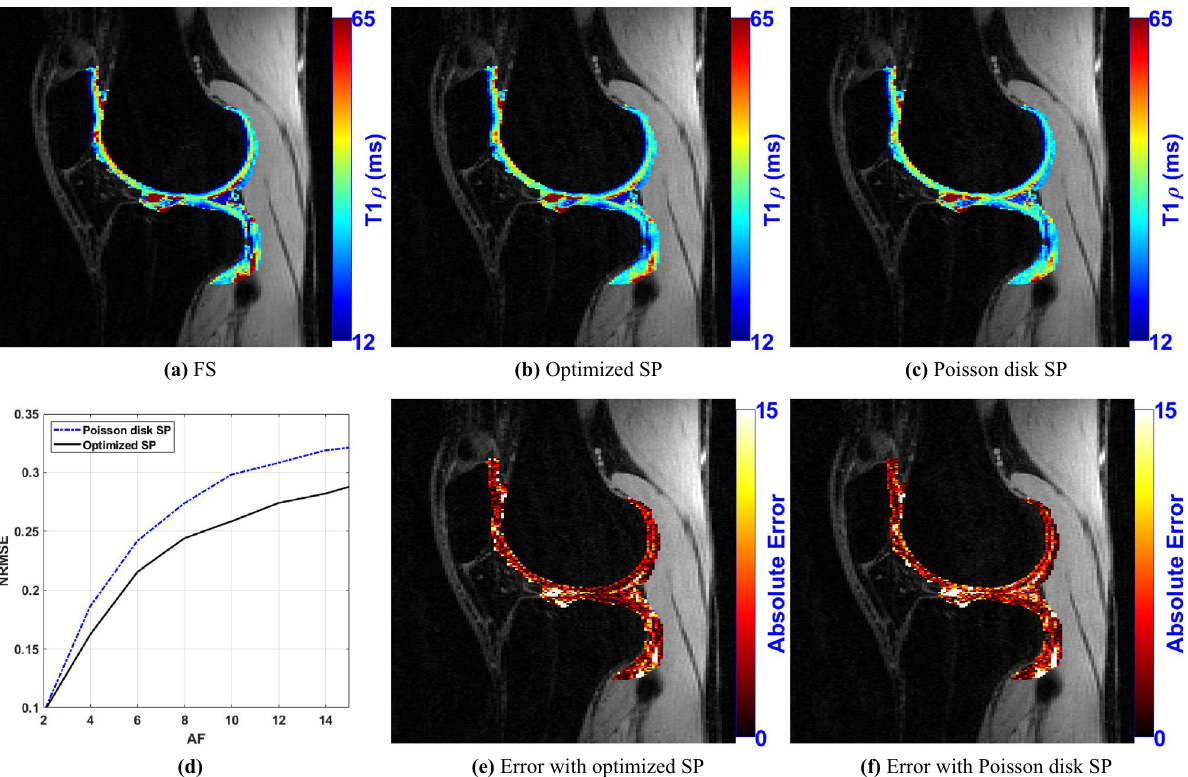
Figure 10. Comparison of T 1 ρ maps obtained with Poisson disk and optimized SP. Illustrative T 1 ρ maps obtained with fully sampled (FS) parallel MRI in ( a ), with optimized SP with AF = 4 in ( b ), and with Poisson disk SP with AF = 4 in ( c ). In ( d ), the NRMSE for different AF is shown. The point-wise error map between the T 1 ρ maps obtained between FS and optimized SP are shown in ( e ), and between FS and Poisson disk SP are shown in ( f ).